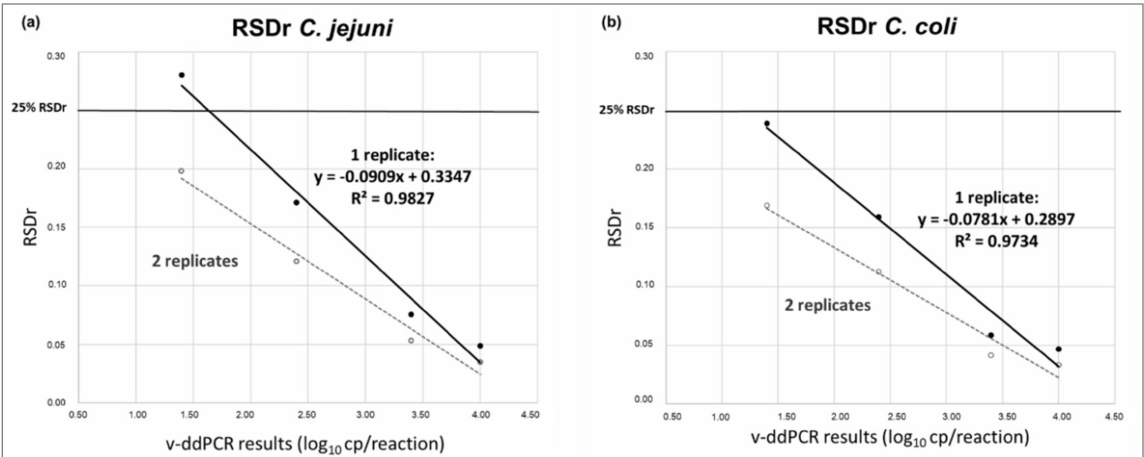
Figure 1. Relative standard deviation of repeatability (RSDr) calculated under repeatability conditions for ( a ) C. jejuni and ( b ) C. coli . Estimation of LOQ (RSDr value of 25%) for one tested replicate (solid- filled points and line) and for two replicates (non-filled points and dashed